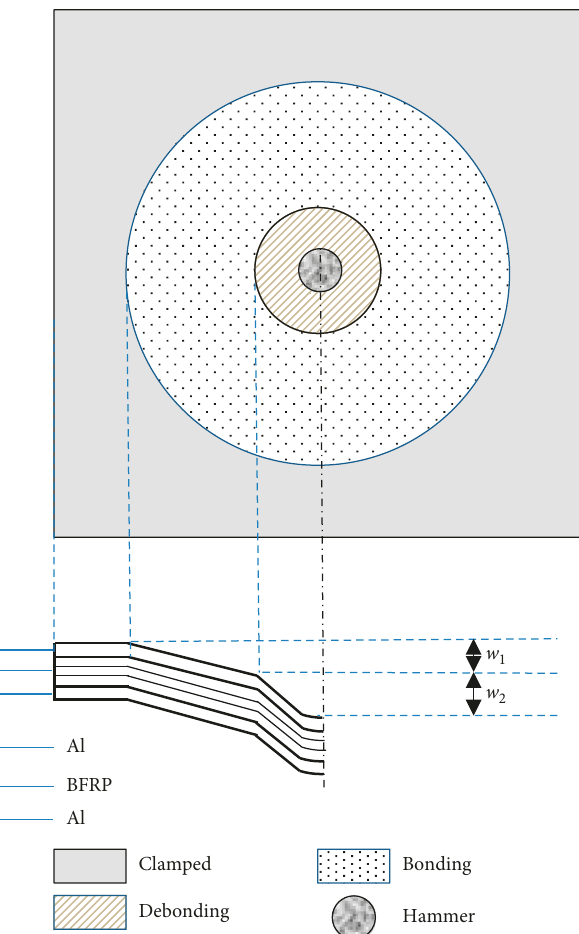
Figure 9: Illustration of deflection components of the BFML plate under drop-weight impact.